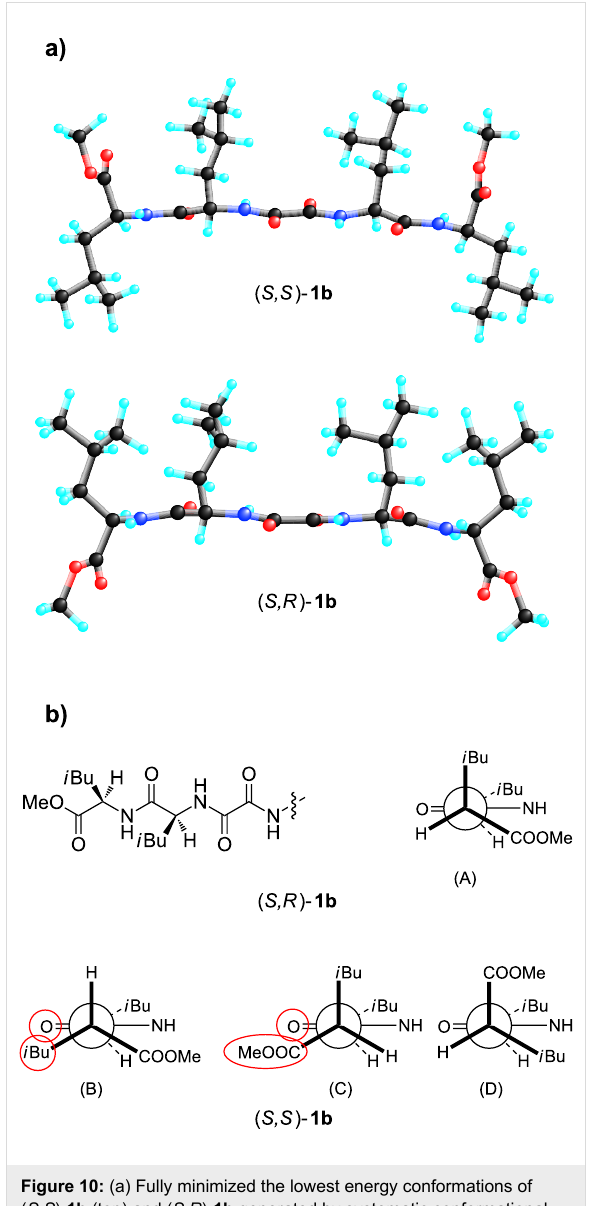
Figure 10: (a) Fully minimized the lowest energy conformations of ( S,S )- 1b (top) and ( S,R )- 1b generated by systematic conformational search (SYBYL package; second graphic); (b) Partial Newman projec- tions of two stereogenic centers of ( S,R )- 1b and ( S,S )- 1b showing conformations with cis -arrangement of i -Bu groups in the former (A) and trans - (B, D) and cis - (C)-arrangements of i -Bu groups in the latter.